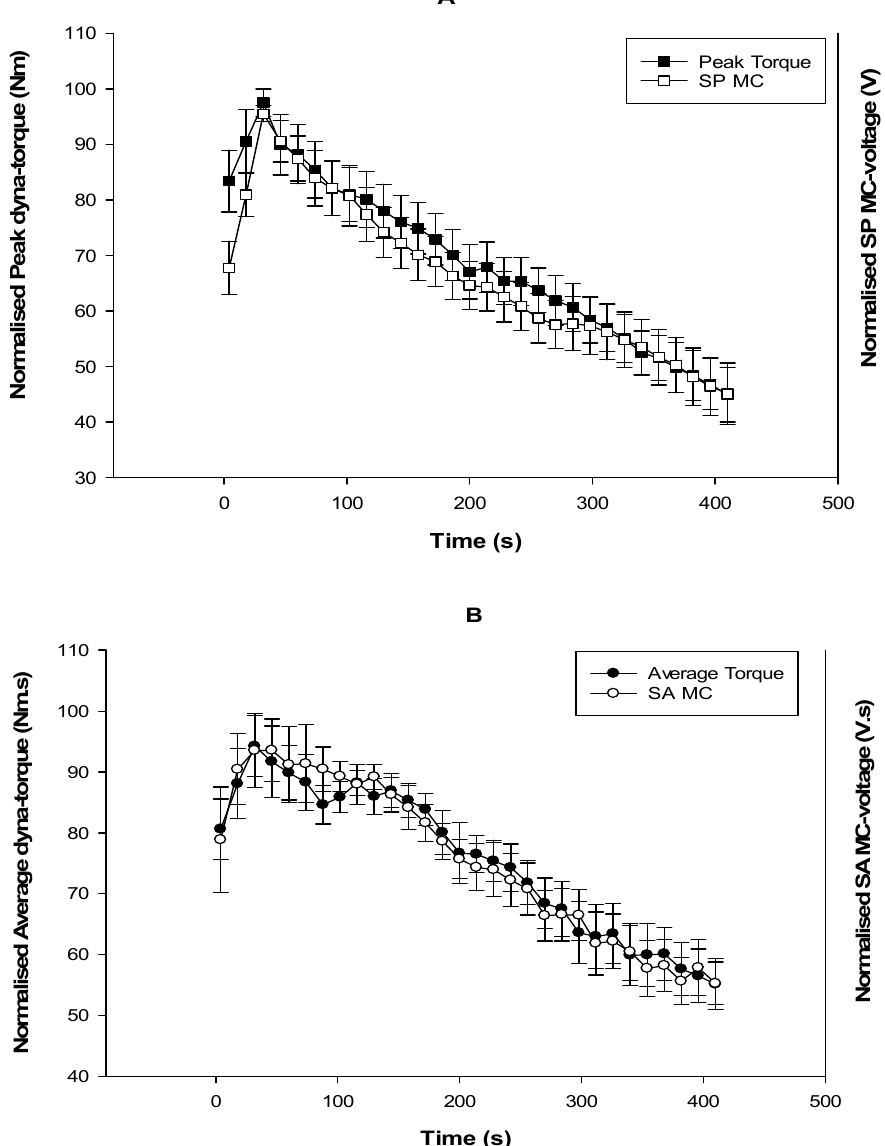
Figure 7. Rectus femoris fatigues in SCI participants represented by their mean normalized dyna-torque and mean normalized MC voltages during FES-evoked contractions ( A ) Peak dyna-torque and SP MC voltage throughout 30 contractions over 400 s; ( B ) Average dyna-torque and the SA MC-voltage throughout 30 contractions over 400 s. Data are mean ± standard error.